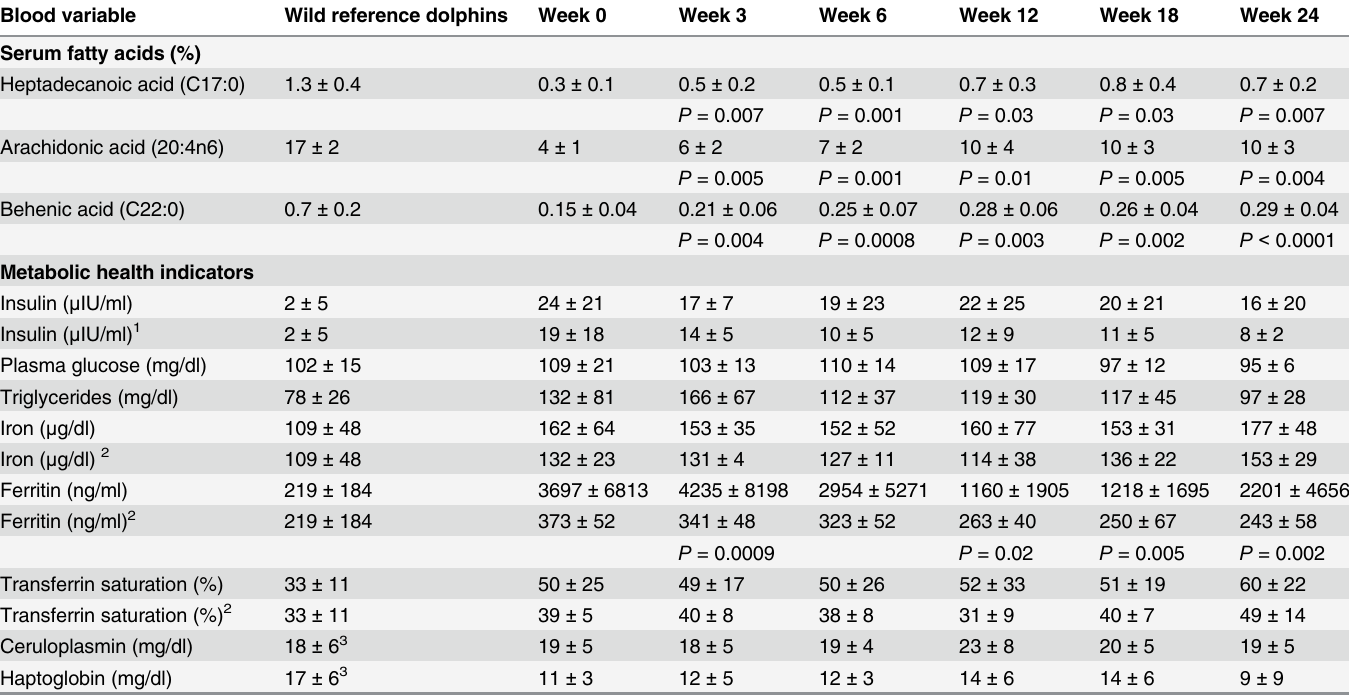
Table 3. Blood-based indicators of metabolic syndrome and fatty acid values during 24-week feeding study with six bottlenose dolphins on modi- fied diet and comparisons of values during weeks 3, 6, 12, 18, and 24 compared to baseline week 0. Significant P values are provided. Blood